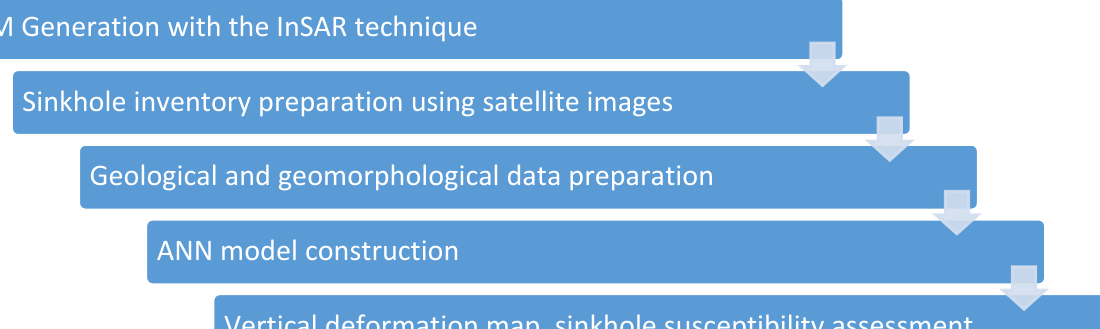
Figure 4. Perpendicular and temporal baseline of the time series data used in this study.